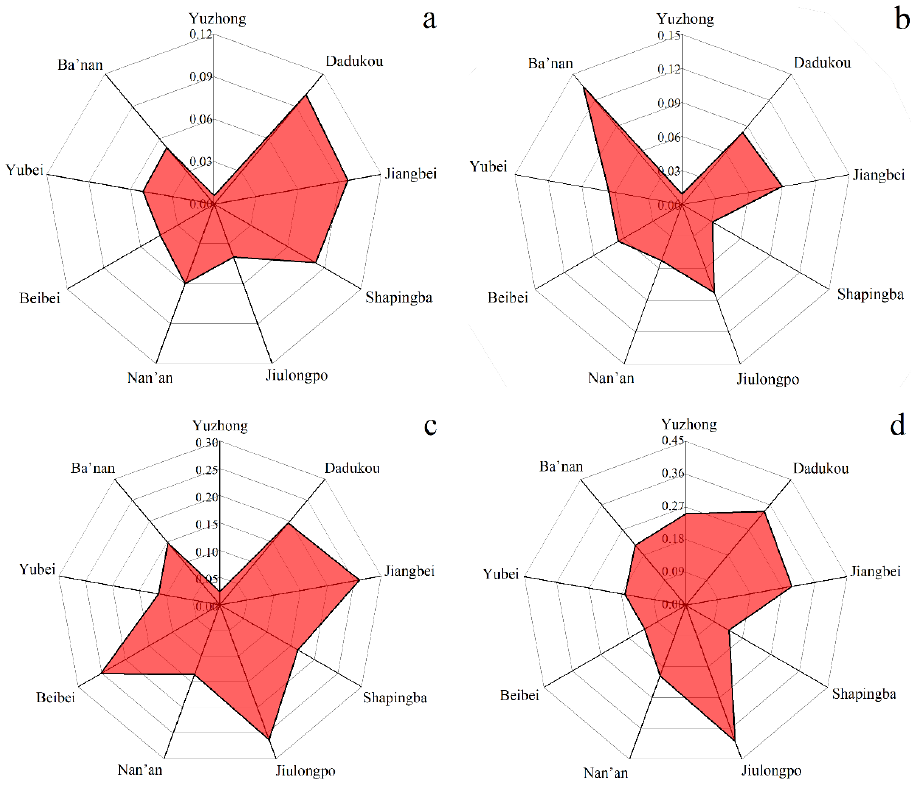
Figure 5. Intra-regional differences of The Dagum Gini coefficient. ( a ) Rail transit mode; ( b ) private car mode; ( c ) bus mode and ( d ) walk mode.